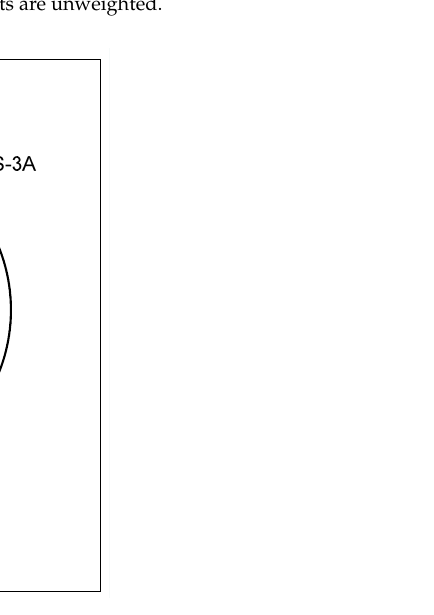
Figure 3. Venn diagram illustrating proportional overlap between self-identified anxiety, GAD-2 and